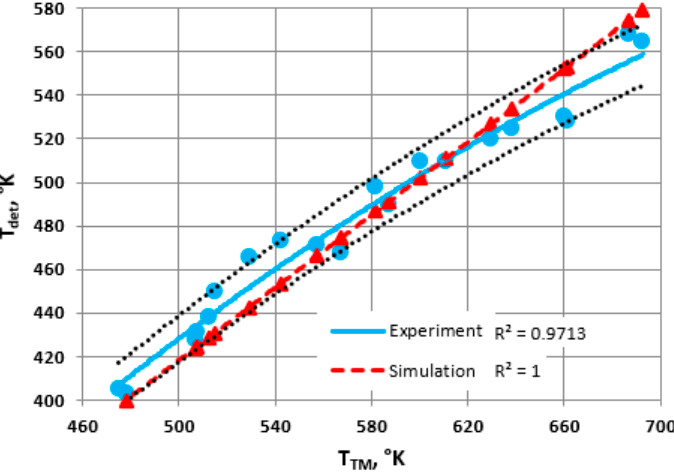
Figure 6. Relationship between T TM and T det of engine temperature according to experimental and numerical evaluation data.